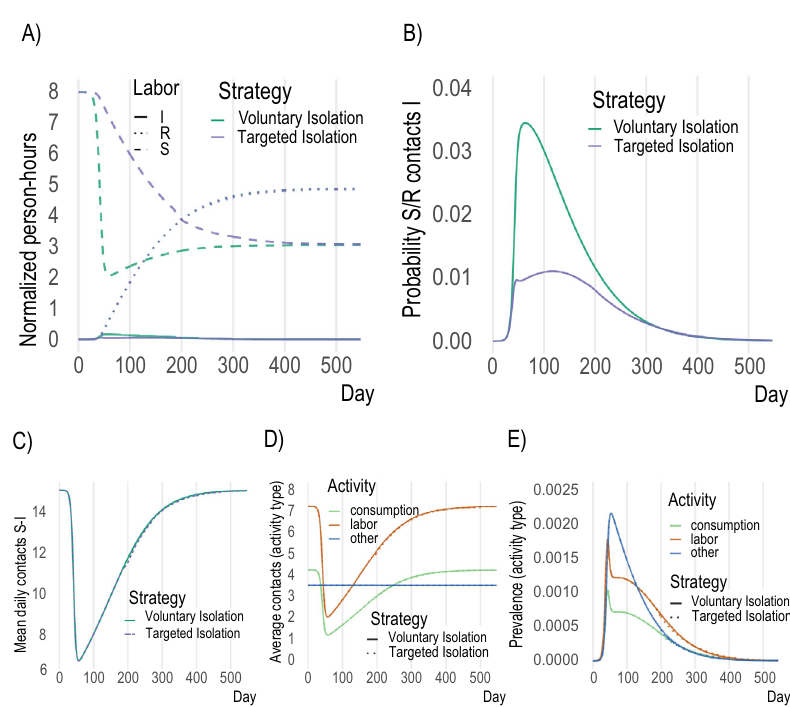
Fig. 3 Key model mechanisms. A In voluntary isolation, susceptible individuals withdraw from economic activity due to the presence of infectious individuals (green dashed), while under targeted isolation susceptible agents engage in much more economic activity (blue dashed). B More infectious agents at activity sites under voluntary isolation lead to higher probability of infection throughout epidemic. C – E overall contacts, contacts by activity and prevalence (% infectious) do not change meaningfully across voluntary and targeted isolation, as the same infection outcomes are achieved despite enabling far more activity by susceptible individuals with targeted